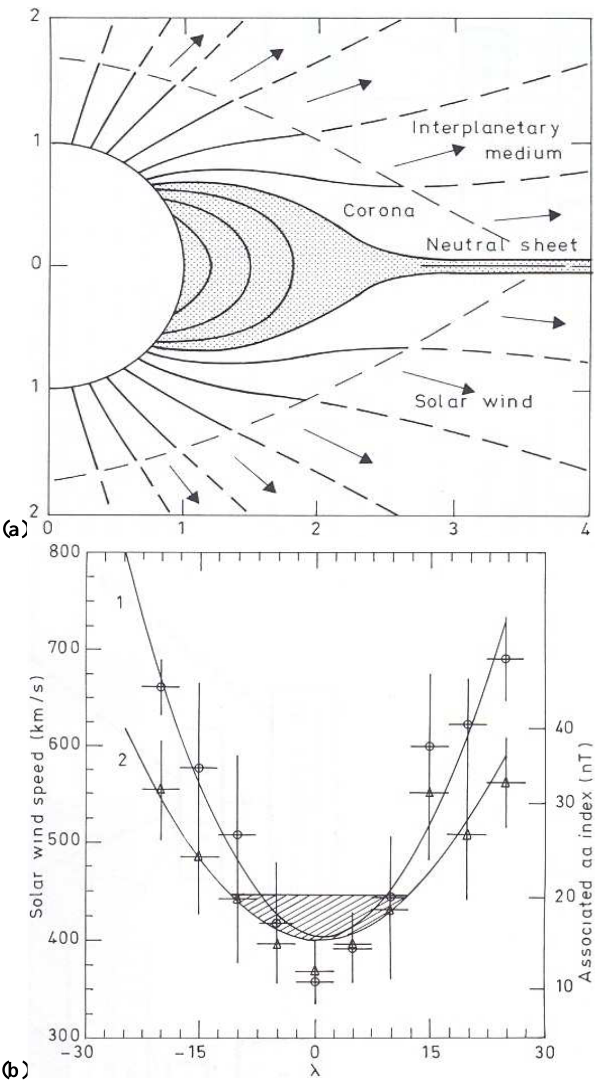
Figure 1 : panel a : Model of dipolar field submitted to the internal pressure of the solar plasma flow (Pneuman and Kopp, 1971; reproduced by Simon and Legrand, 1989); panel b : Average distribution in the ecliptic plane of the solar wind velocity (scale on the left) in 1976 (circles) and 1977 (triangles) as a function of the angular ) in degrees to the neutral sheet (distance ( = 0) (Bruno et al., 1986). Scale on the right: the velocity associated aa index according to Svalgaard (1977). The hatched area shows the slower solar wind speed (Vs £ 450 km.s -1 ) and as a consequence the correlated thickness of its coronal source: the “slow wind sheet”.